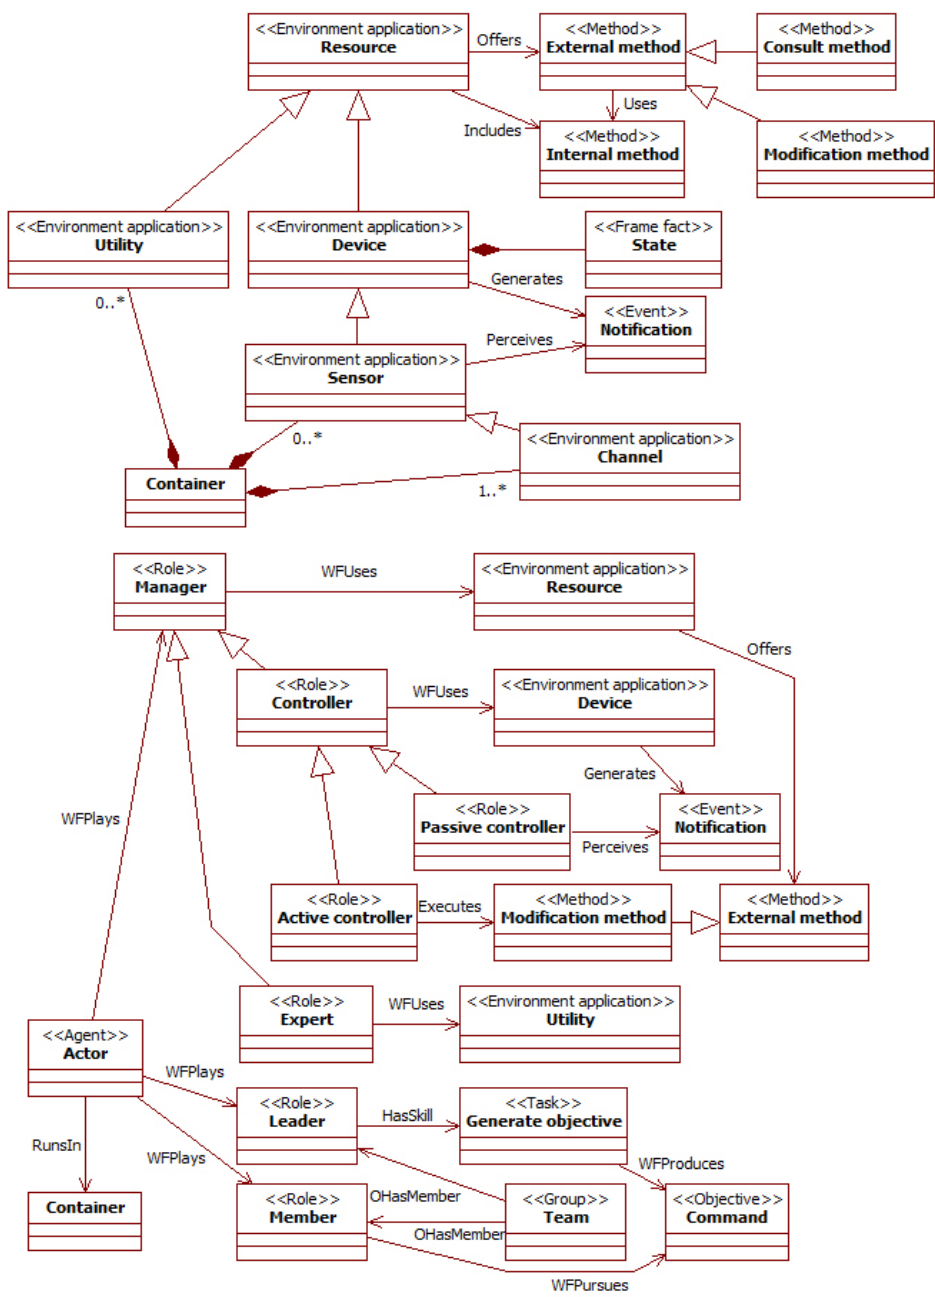
Figure 1. Partial metamodel of agent-based concepts for sensor